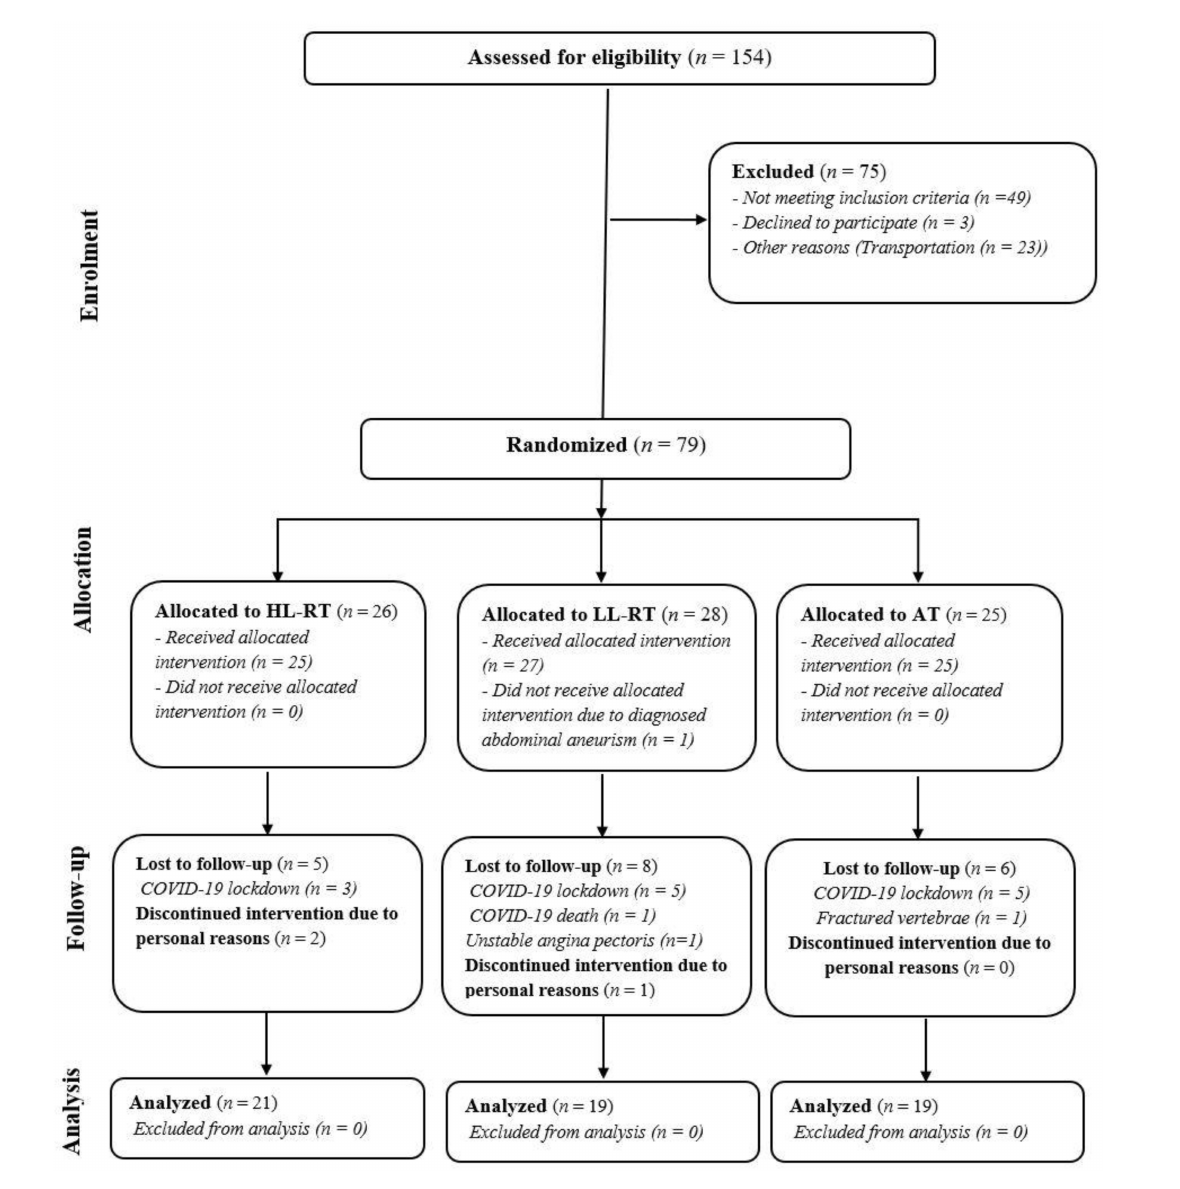
FIGURE1 CONSORT flowchart of the study. HL-RT, high load-resistance training; LL-RT, low load-resistance training; CON, aerobic training; COVID-19,